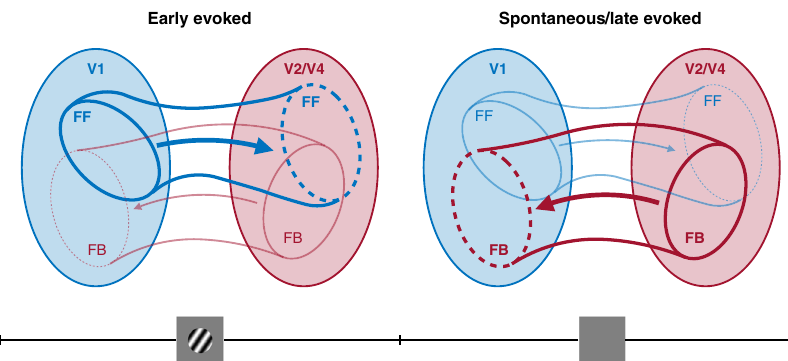
Fig. 7 Summary of results. During the early evoked period, interactions between areas tend to be feedforward-dominated. Later during the evoked period and during the spontaneous period, interactions between areas become feedback-dominated. Furthermore, feedforward- and feedback-dominated interactions involve different population activity patterns. Larger ellipses represent the set of all activity patterns one might observe in either the V1 or the V2/V4 populations. The smaller ellipses represent the activity patterns most related across the